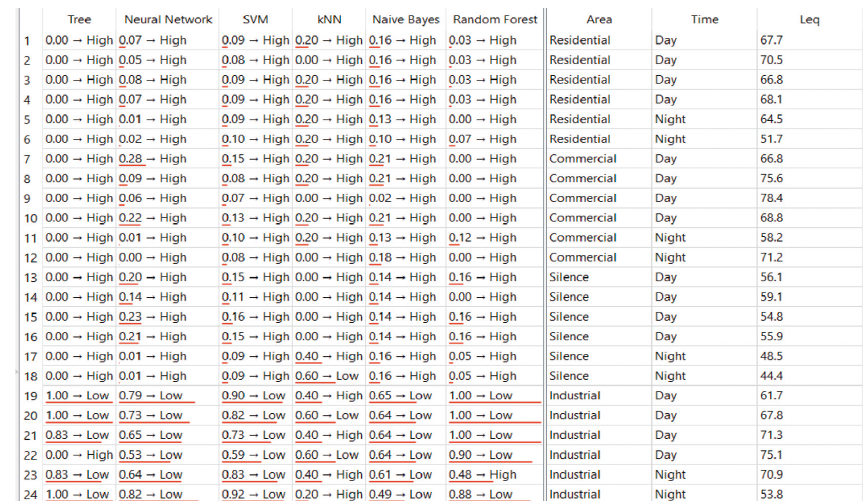
Figure 17: Prediction of low noise level using different ML models for the input instances with probability values (0.001–1.00).